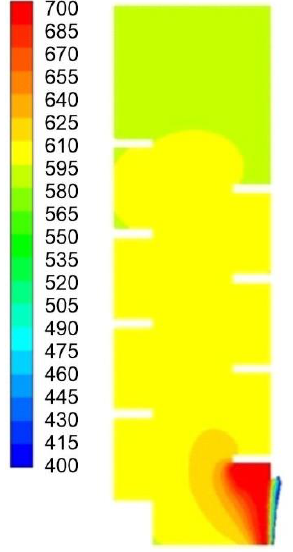
Figure 12. Temperature distribution in the building after axial fan application. Temperature was measured in (K). The above comparisons showed the benefits of using mechanical fans during fire- fighters’ activities in the event of internal fires. They may significantly lower the temper- ature inside the facility, increase visibility and reduce the concentration of harmful fire gases. The use of the fan also caused a slight increase in pressure in the staircase. This fact may turn out to be worth analyzing, because with an excessively high overpressure in the cage, it may be impossible for less fit people to open the door from their apartments. 4. Discussion Fire safety engineering is recognized as a unique branch of engineering [28]. When reviewing the needs of the building, there may be a number of objectives relevant to the fire strategy. The types of ventilation installed in a building, including gravity, mechanical and fire ventilation, influence its safety during both standard and fire conditions. Addi- tionally, during emergencies, firefighters use portable fans to speed up fire extinguishing.